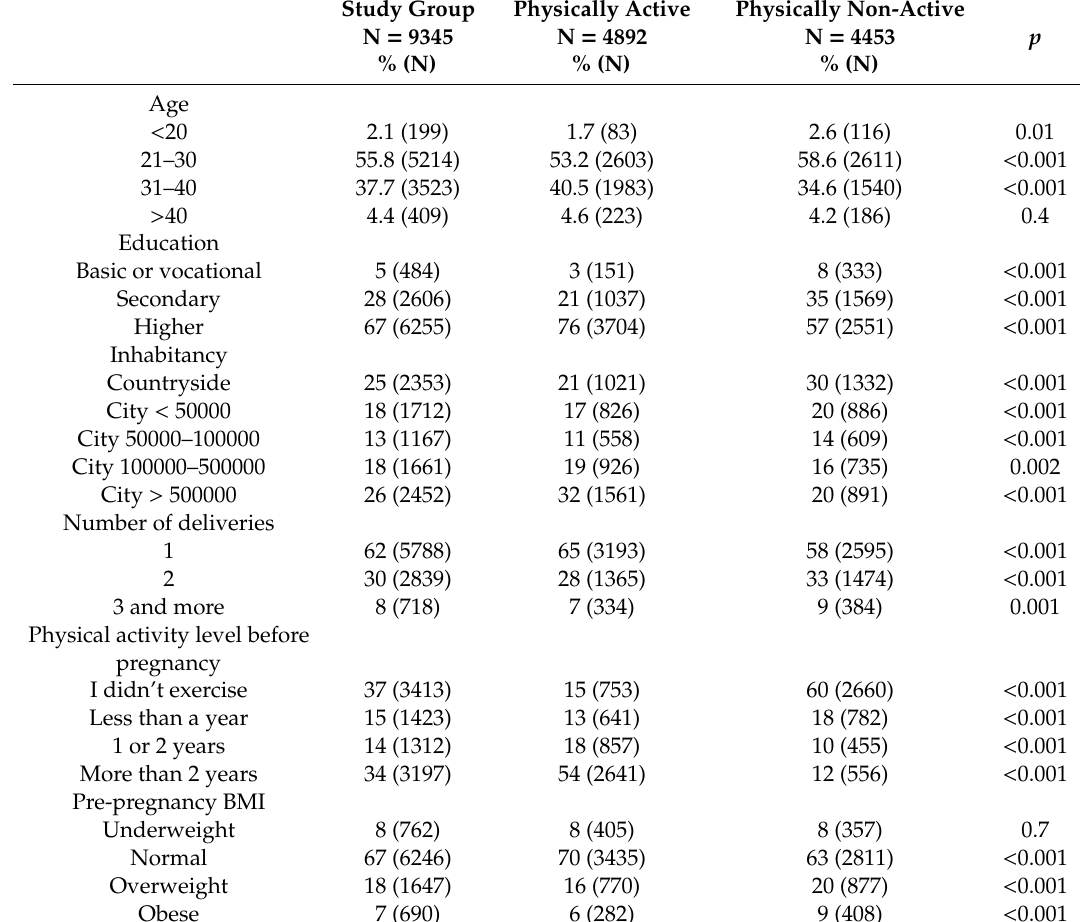
Table 1. Basic characteristics of the study